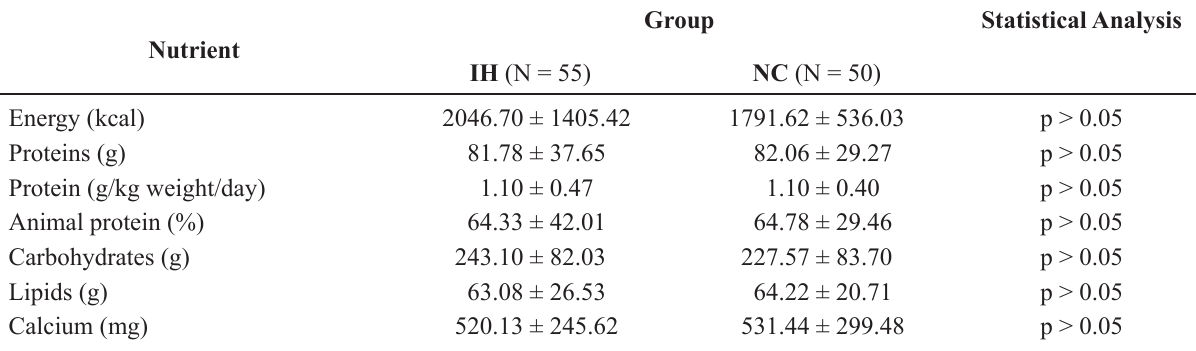
Table 3 – Description of median and standard deviation of the composition of daily food intake in the different studied